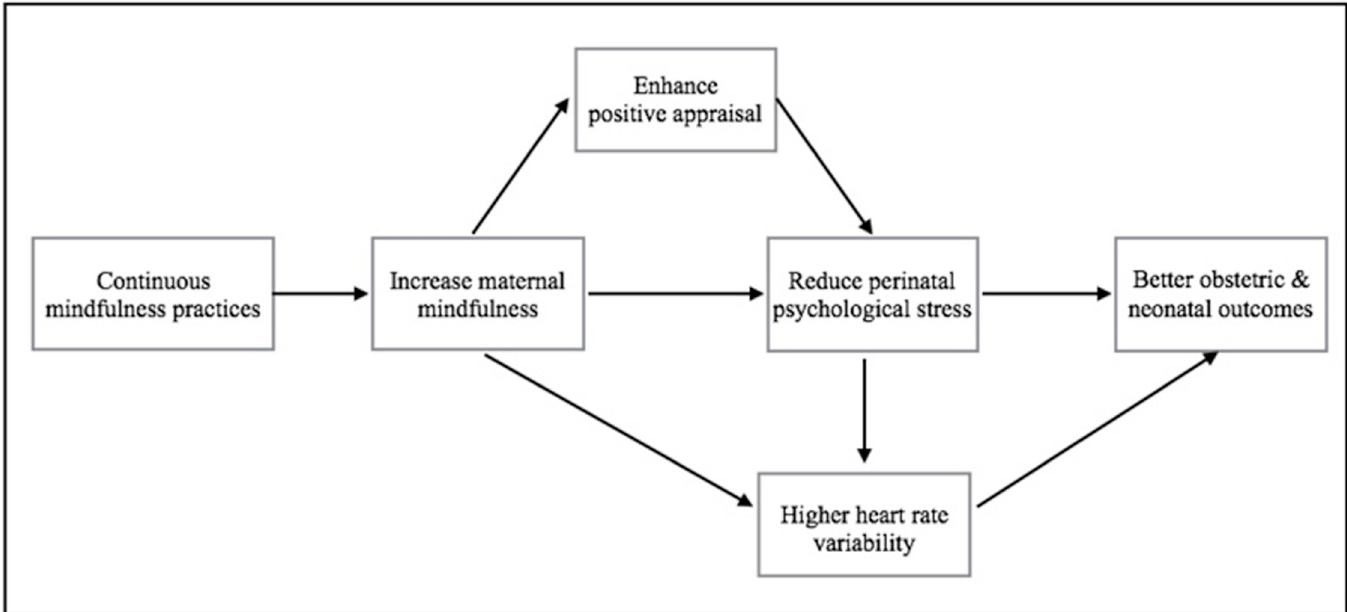
Fig 1. Conceptual framework.